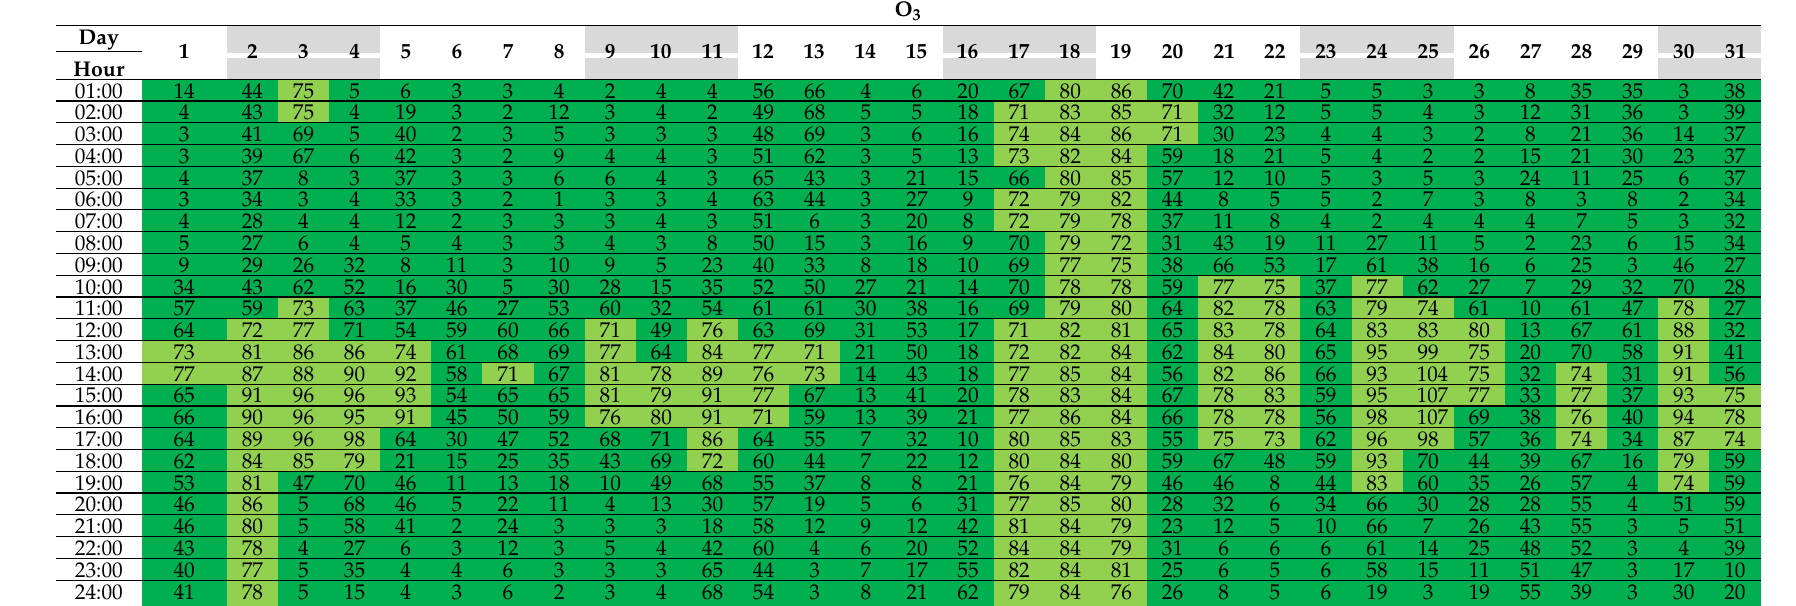
Table 5. Daily and hourly O 3 content changes, with the hourly Polish AQI, average values for Krak ó w, March 2018 [39] (weekend marking in